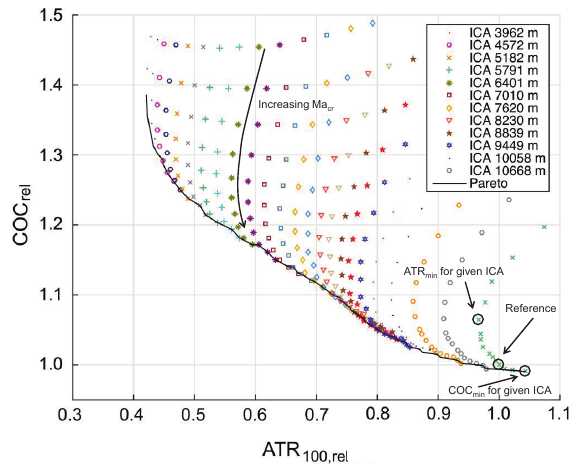
Figure 7. Pareto front (black) for route DTW-FRA (Detroit-Frankfurt) obtained from all feasible ICA and Ma cr combinations (colored symbols) with resulting ATR rel , i , k vs. COC rel , i , k changes relative to the route-specific.